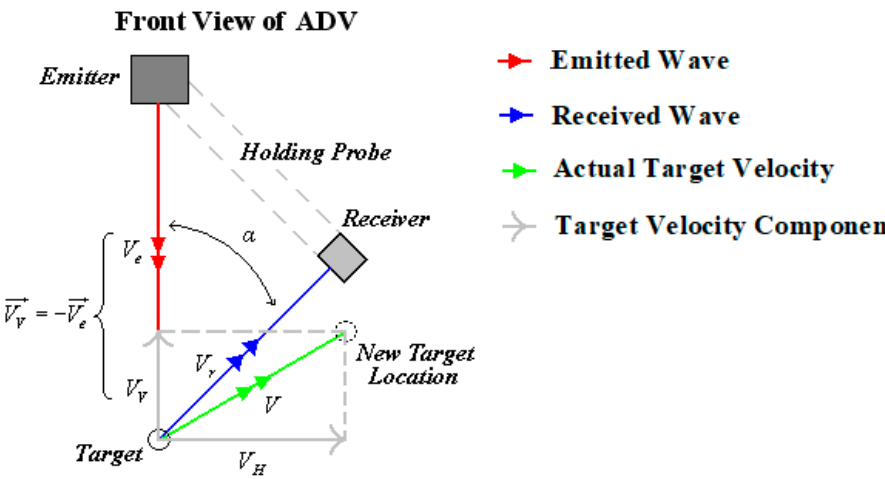
Figure 2. Working principle of a bistatic acoustic Doppler velocimeter (ADV) configuration.